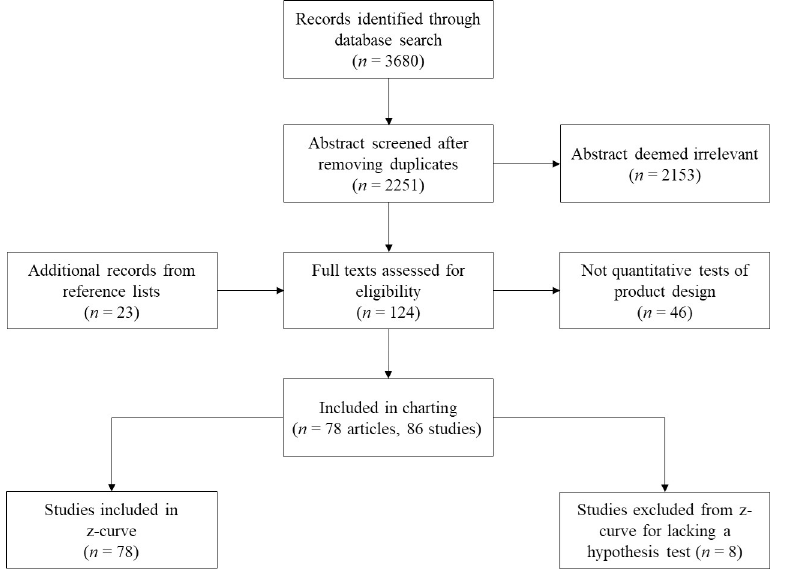
Fig 1. PRISMA diagram of study selection and coding